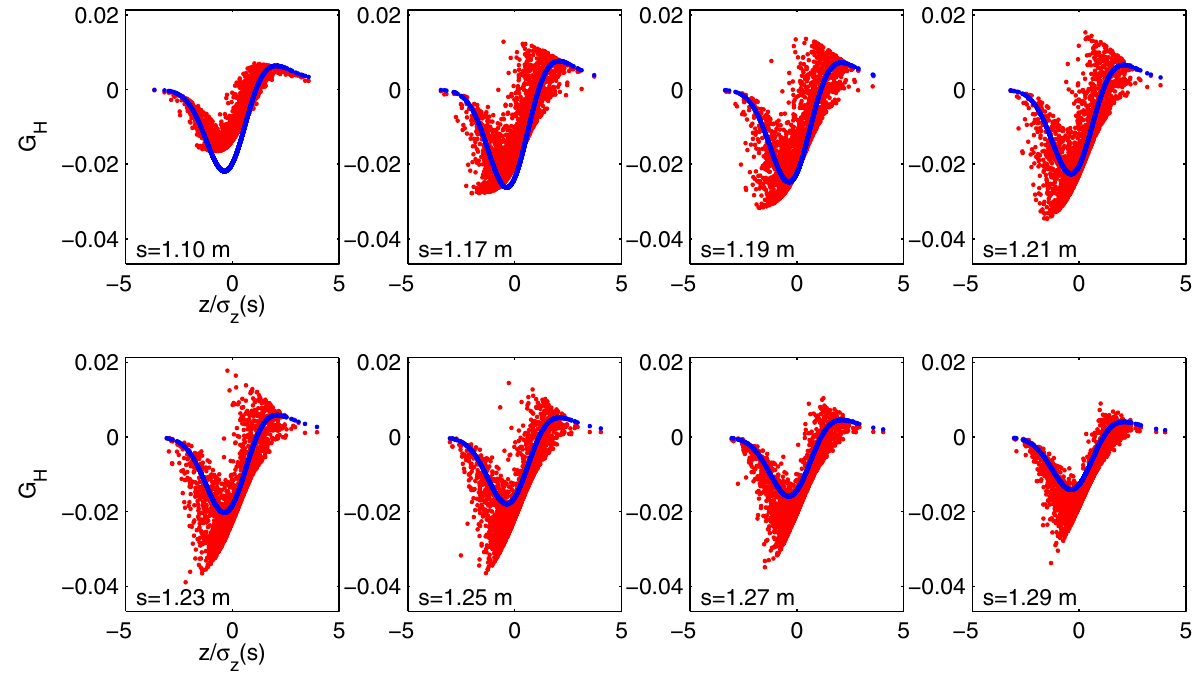
(cid:3) ~ x; ~ z; s (cid:5) vs ~ z for the representative particle of the bunch at each s for the thick-bunch case with (cid:18) FIG. 9. (Color) G H (cid:1) 10 (cid:4) 3 . The red dots are obtained from Eq. (134), and the blue line is the rigid-line bunch result in Eq. and (cid:12) H 0